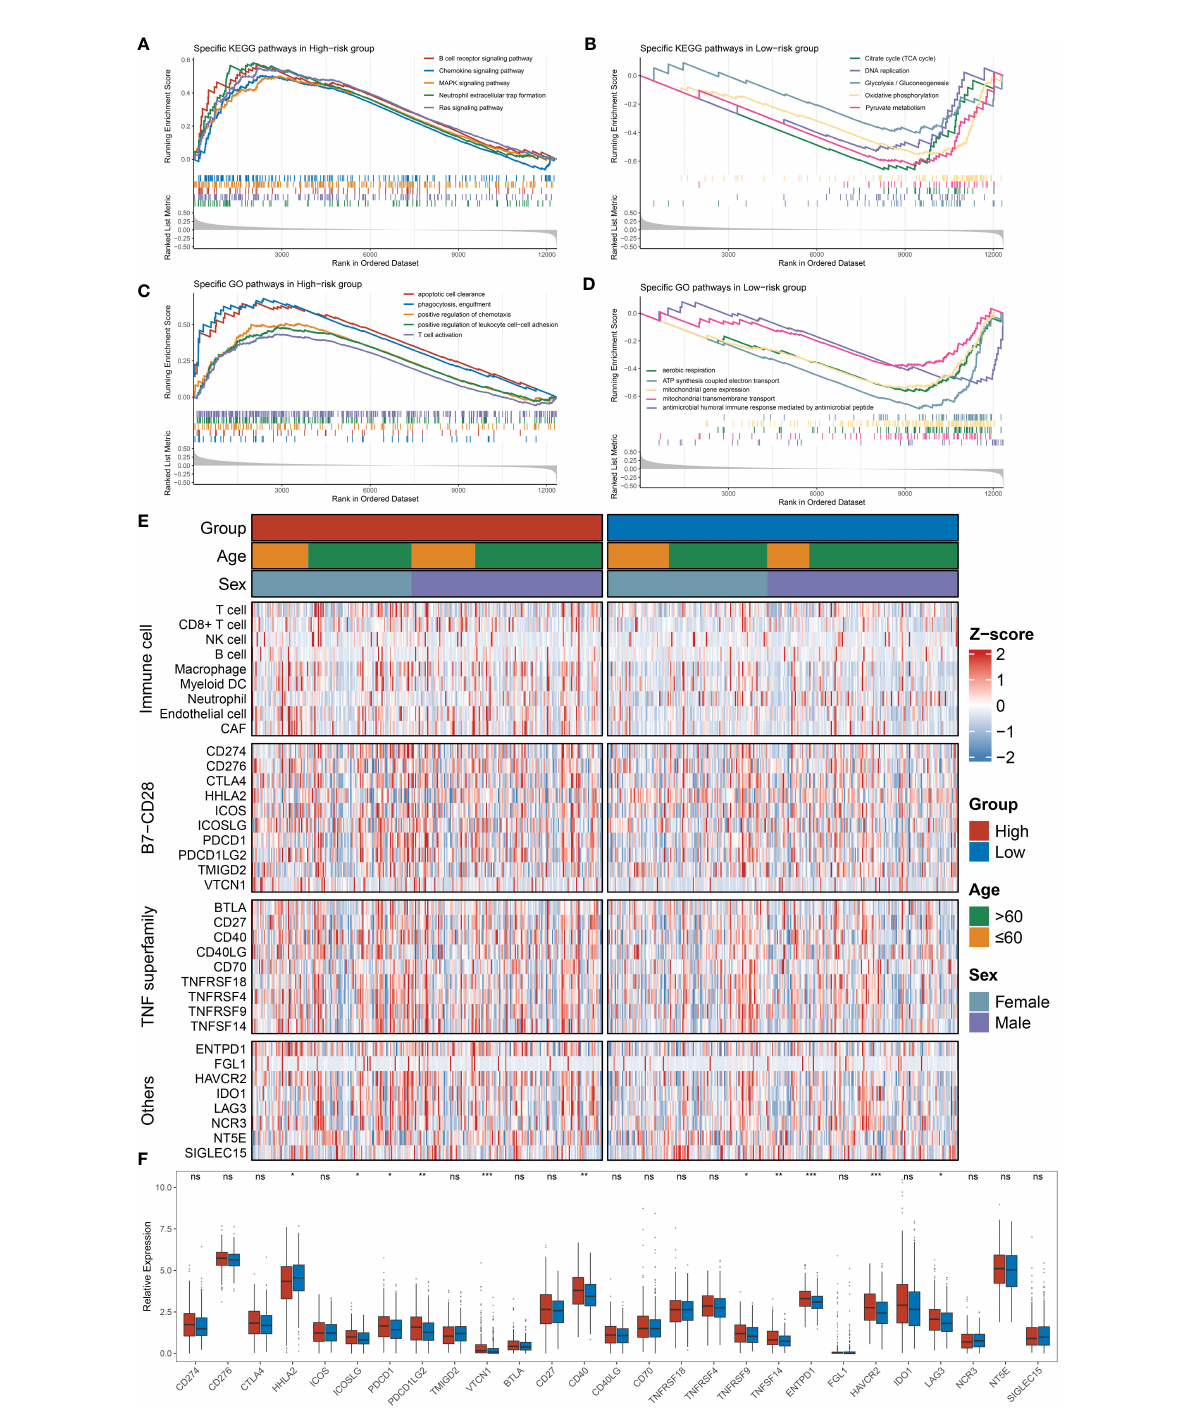
FIGURE 5 Functional enrichment analysis and immune in fi ltration analysis were performed in high- and low-risk groups. (A, B) The top fi ve KEGG-enriched pathways and immune landscapes in the high- and low-risk groups. (C, D) The top fi ve GO-enriched pathways and immune landscapes in the high- and low-risk groups. (E) The heatmaps of eight immune cell and 27 immune checkpoint pro fi les in the high- and low-risk groups. (F) The relative expression of 27 immune checkpoints in the high- and low-risk groups. (ns, none signi fi cance, P> 0.05; *P< 0.05; **P< 0.01; ***P<